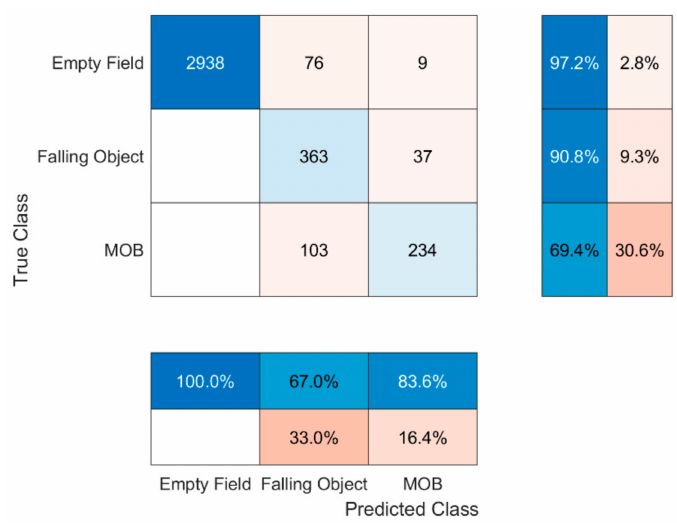
Figure 12. C1 (cid:48) s confusion